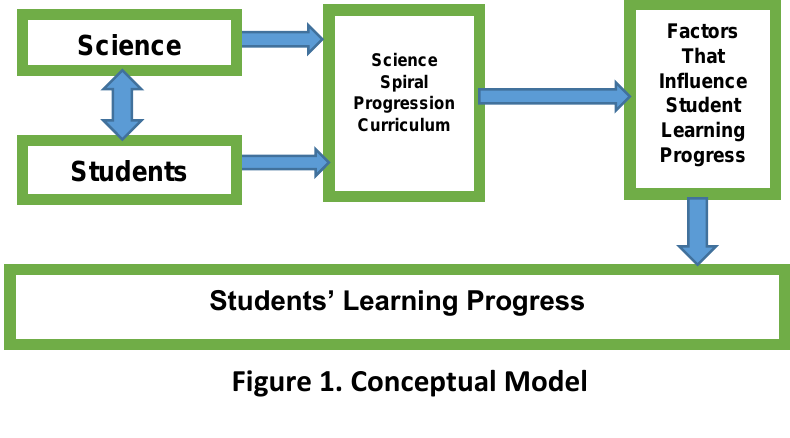
Figure 1. Conceptual